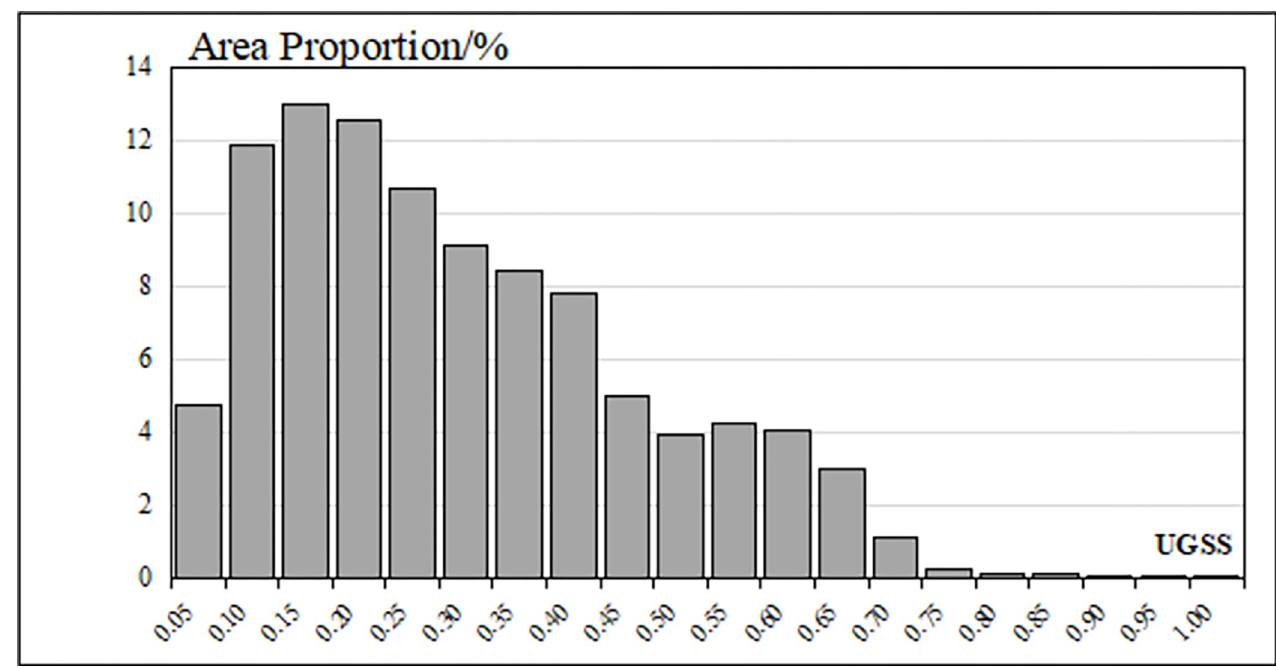
Fig 7. The area distribution of UGSS